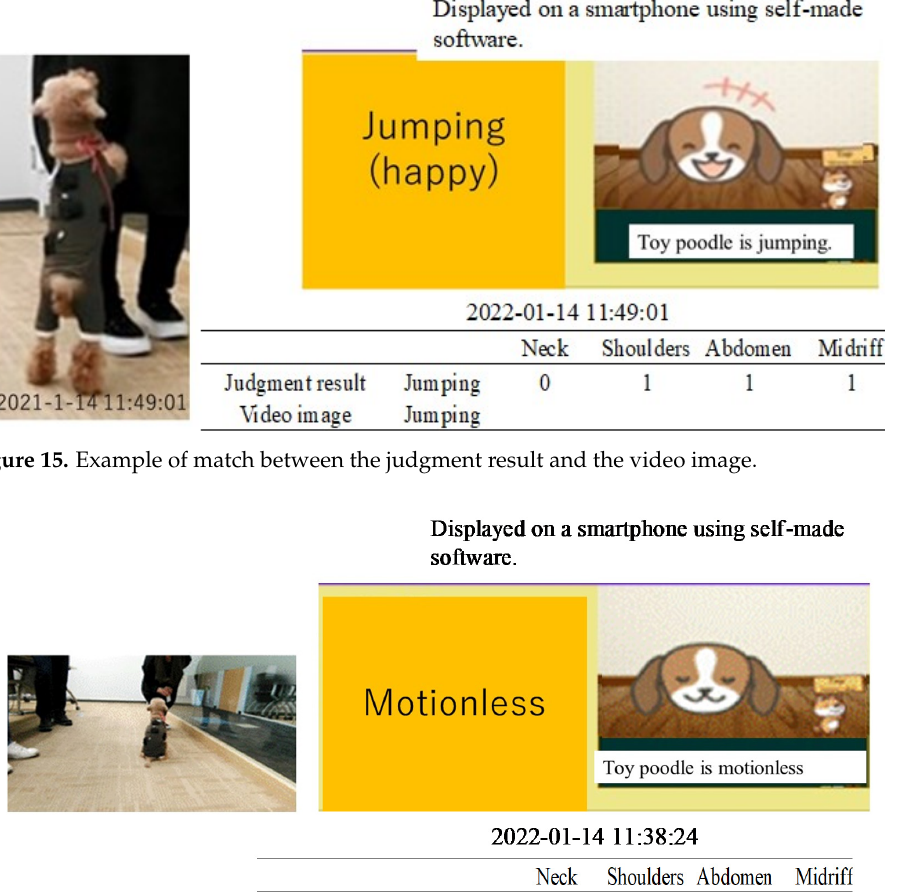
Figure 17. Examples of various matches between the judgment results and the video image.